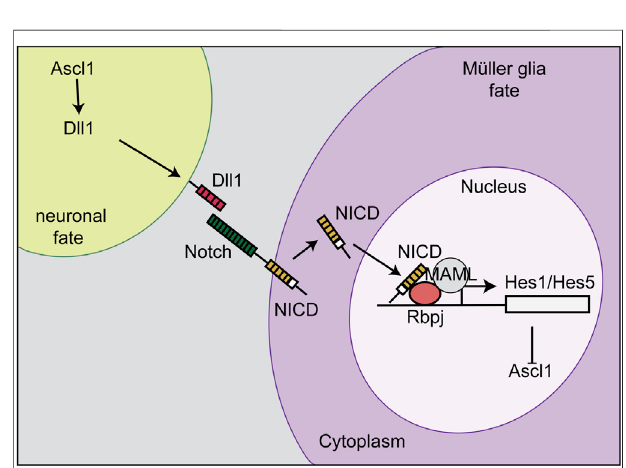
FIGURE 9 | Notch signaling and lateral inhibition. Notch signaling sustains RPC proliferation and prevents differentiation via its downstream effectors, Hes1 and Hes5. The cell that becomes a Müller glia expresses high levels of the Notch receptor, which is stimulated by a Delta ligand (Dll1) on the neighboring cell. The Notch intracellular domain (NICD) is then cleaved, translocatestothenucleus,andbindsRbpjtoinitiatethetranscriptionof Hes1 and Hes5 . Hes1 and Hes5 repress the transcription of Ascl1 . This process initiates Müller glia speci fi cation and represses differentiation, including a photoreceptor